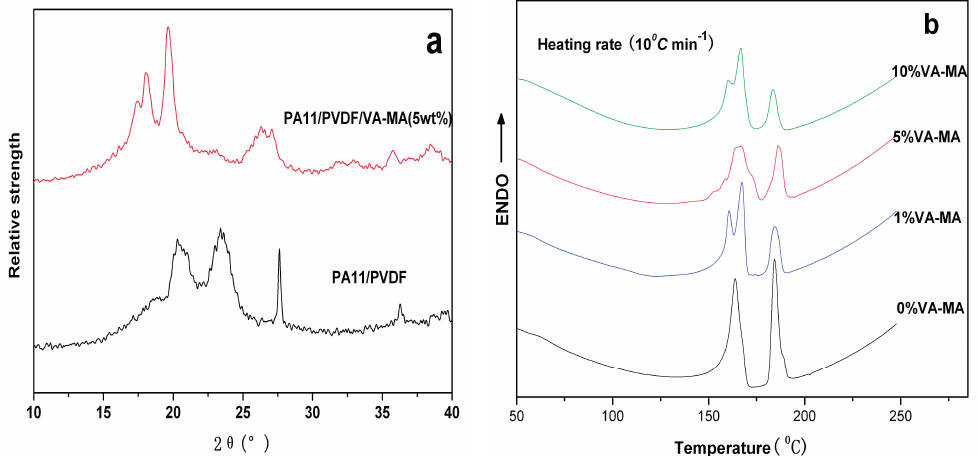
Figure 5. ( a ) The XRD spectra and ( b ) The DSC for PA11/PVDF (40:60) at 5 °C min − 1